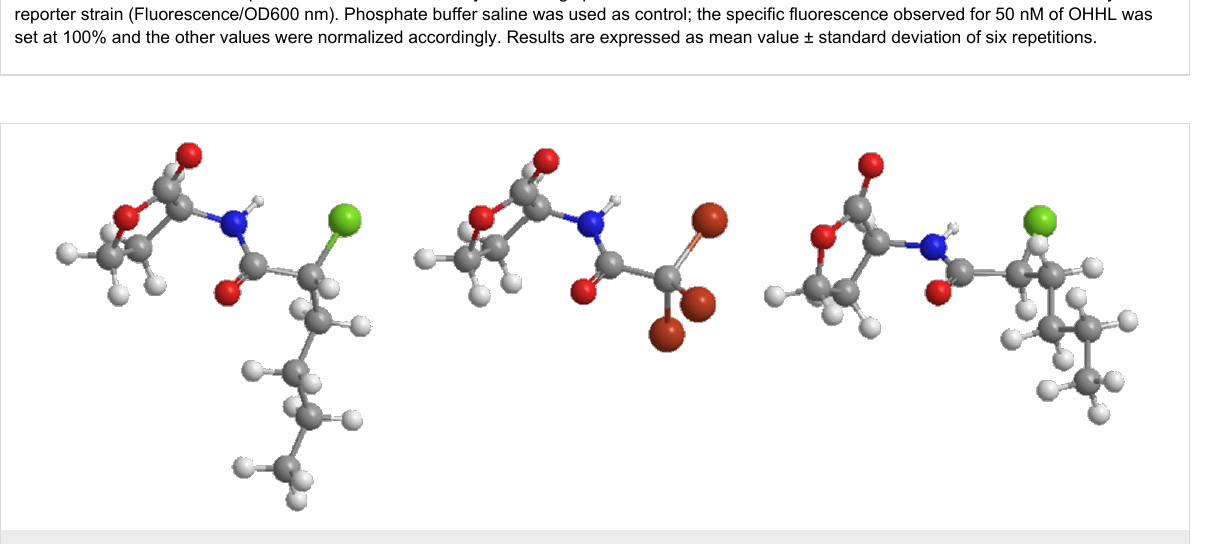
[34]. In summary, it can be suggested that some of these novel halogenated analogues 6 , 8 and especially 11 could be utilized as tools in QS research, e.g., with wild type bacteria or other reporter strains because of their partially retained activity and the absence of antagonistic effects presently